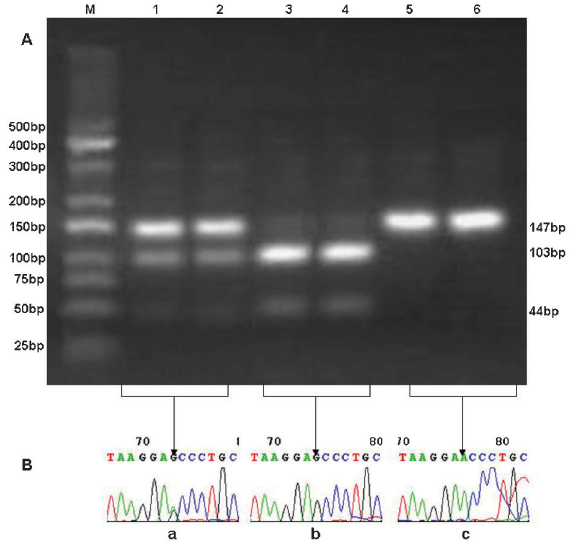
Figure 3. Genotypes of the ELOVL6 single nucleotide poly- morphism (SNP) rs6824447. A , Restriction fragment length polymorphism analyses for determination of rs6824447 genotype (digested by Alu I). The AG genotype shows 3 bands of 147, 103, and 44 bp ( lanes 1 and 2 ), the GG genotype shows 2 bands of 103 and 44 bp ( lanes 3 and 4 ), and the AA genotype shows a band of 147 bp ( lanes 5 and 6 ). B , Nucleotide sequences surrounding the SNP rs6824447. a , AG genotype; b , GG genotype; c , AA genotype. Lane M : DNA